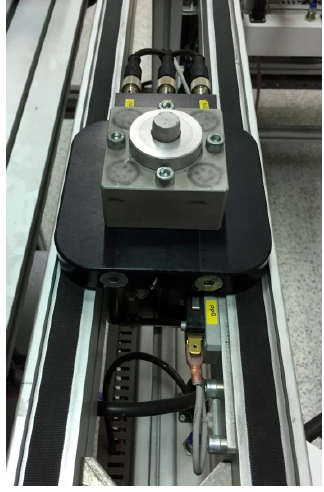
Figure 5. Station FMS-208: Automatic warehouse.